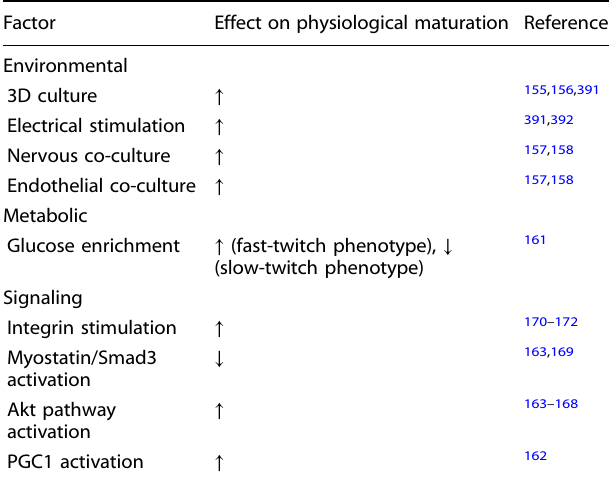
Table 5. Factors in fl uencing skeletal muscle tissue